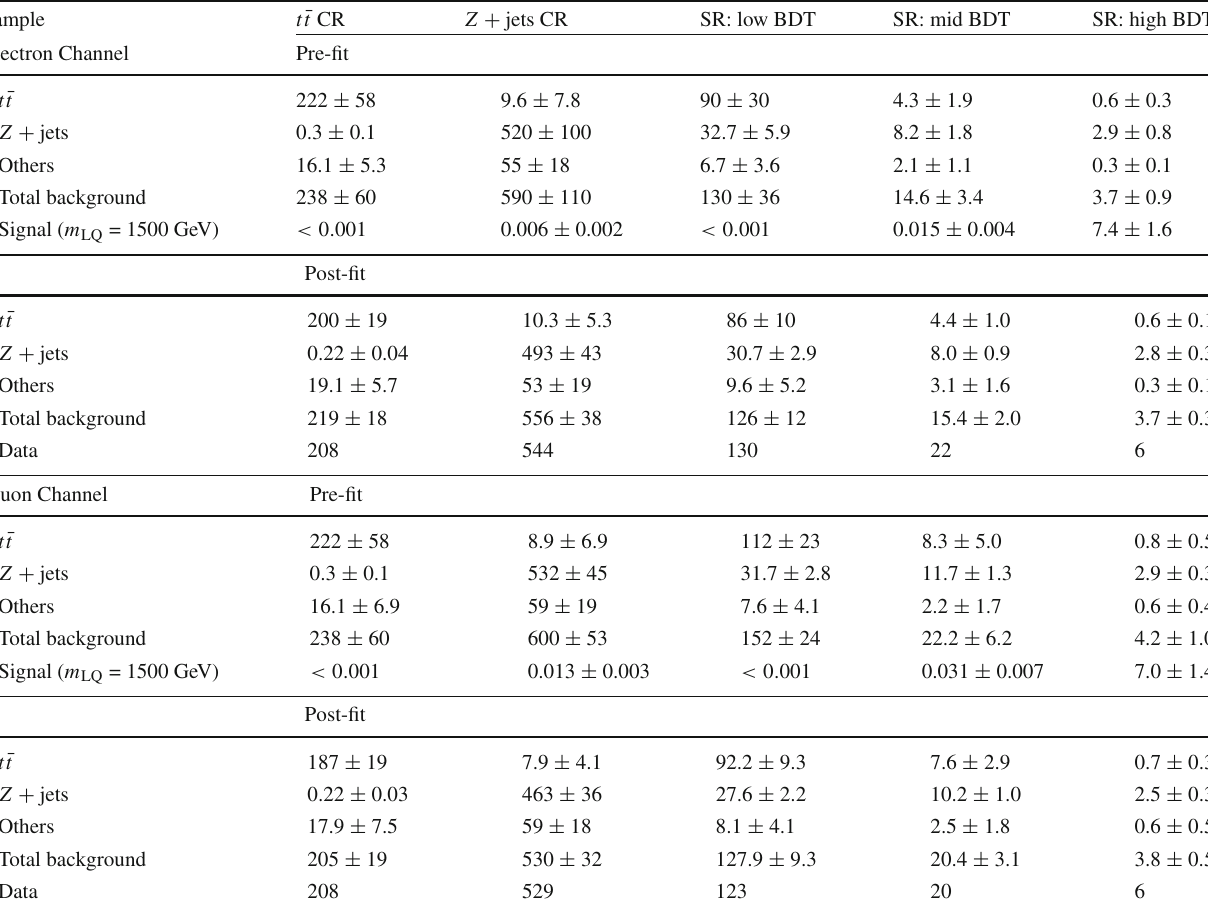
Table 2 Event yields in the signal and control regions before and after the background-only fit to data in the electron and muon channel. The quoted uncertainties include statistical and systematic uncertainties; for the t ¯ t and Z + jets backgrounds no cross-section uncertainty is included since it is a free parameter of the fit. The contributions from single top, t ¯ tV , diboson and W + jets production are included in the ‘Others’ cate-